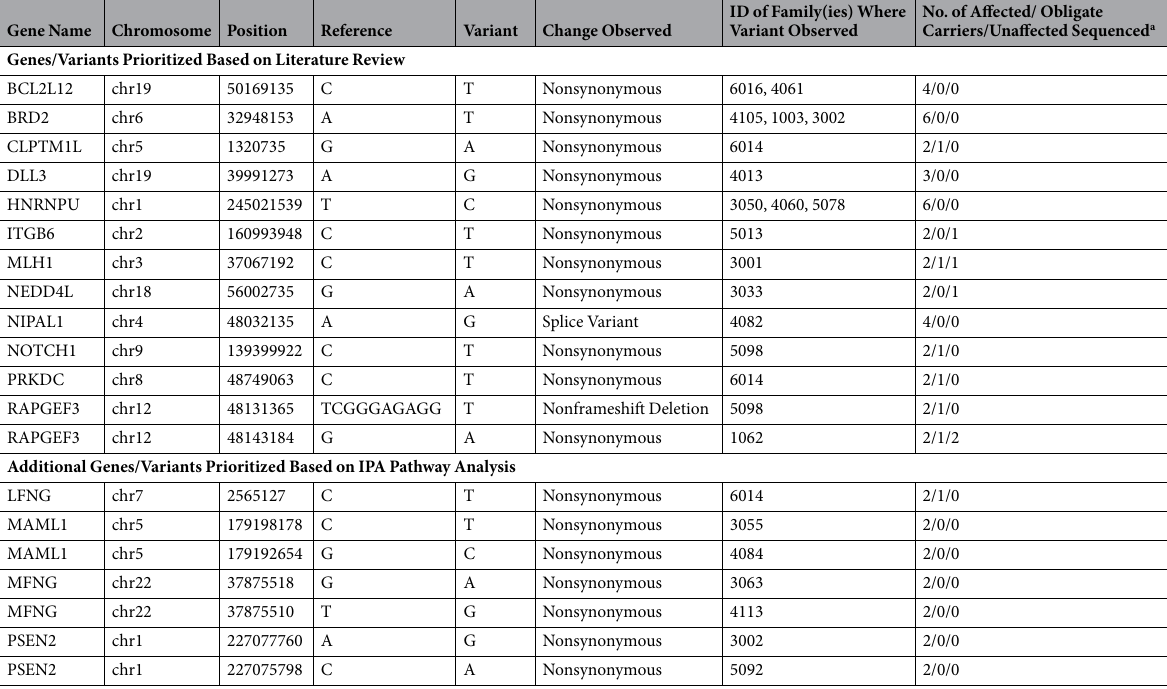
Table 1. Summary of Top Candidate Genes with Rare, Likely Deleterious Variants Linked to NPC Identified in the Taiwan NPC Family Whole Exome Sequencing Study. a Variant was observed in affected individuals/obligate carriers sequenced; not observed in unaffected individuals